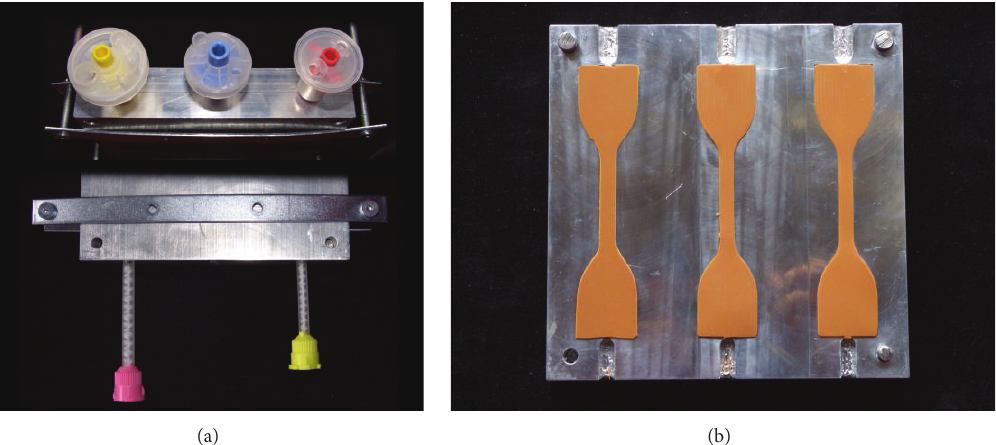
Figure 3: Injection of the impression materials through dedicated, commercially available tips (a) allowed the production of up to three samples at the same time